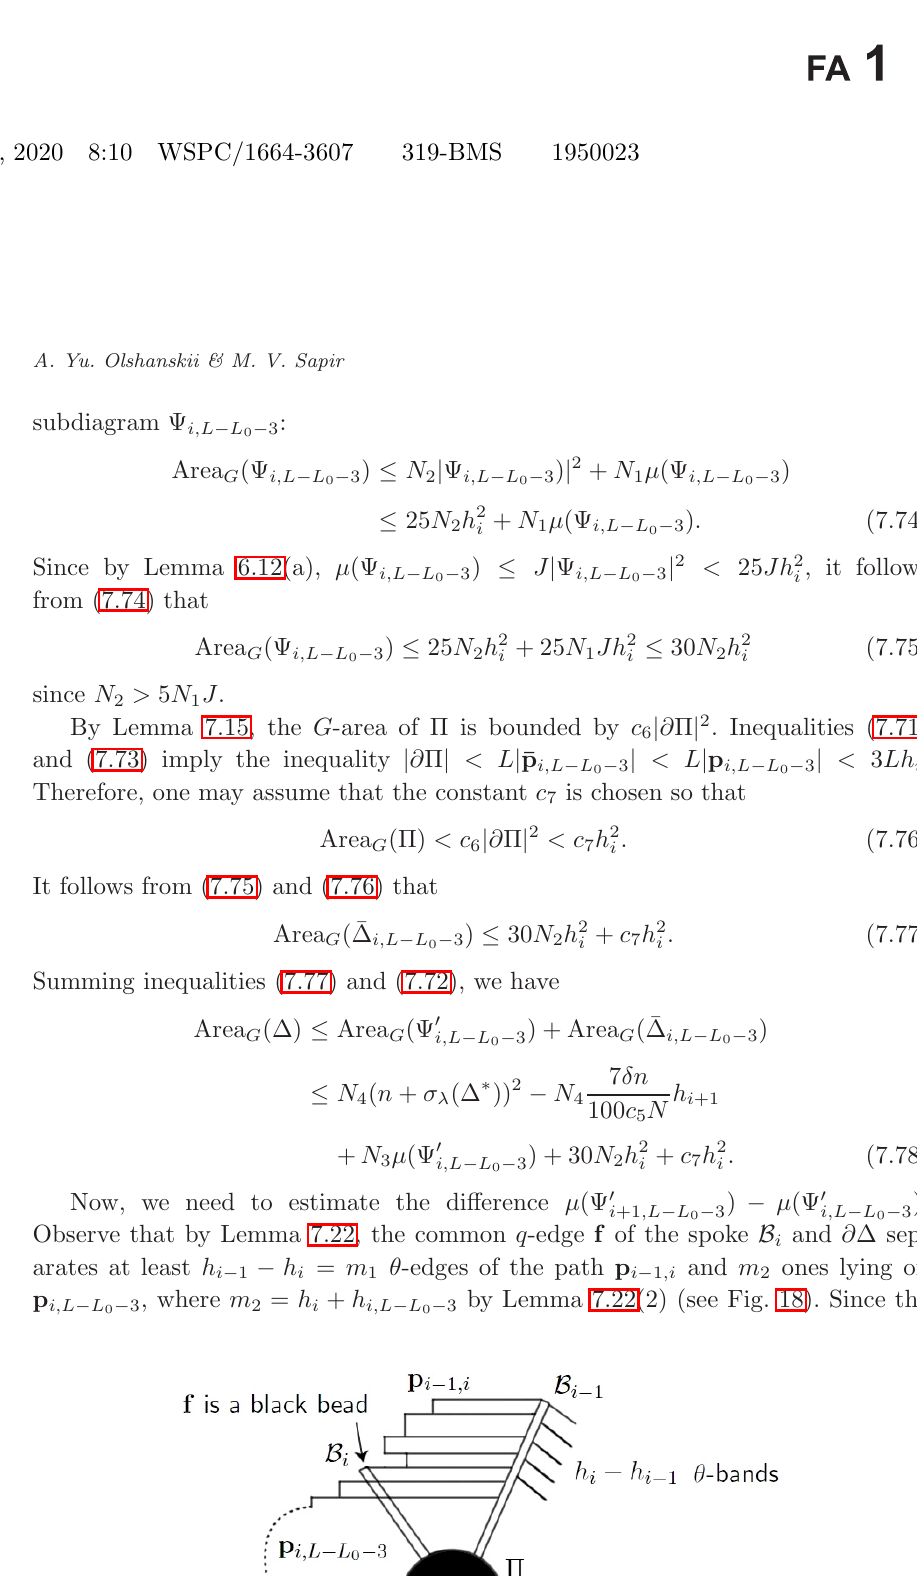
Fig. 18. μ (Ψ (cid:2) i +1 ,L − L